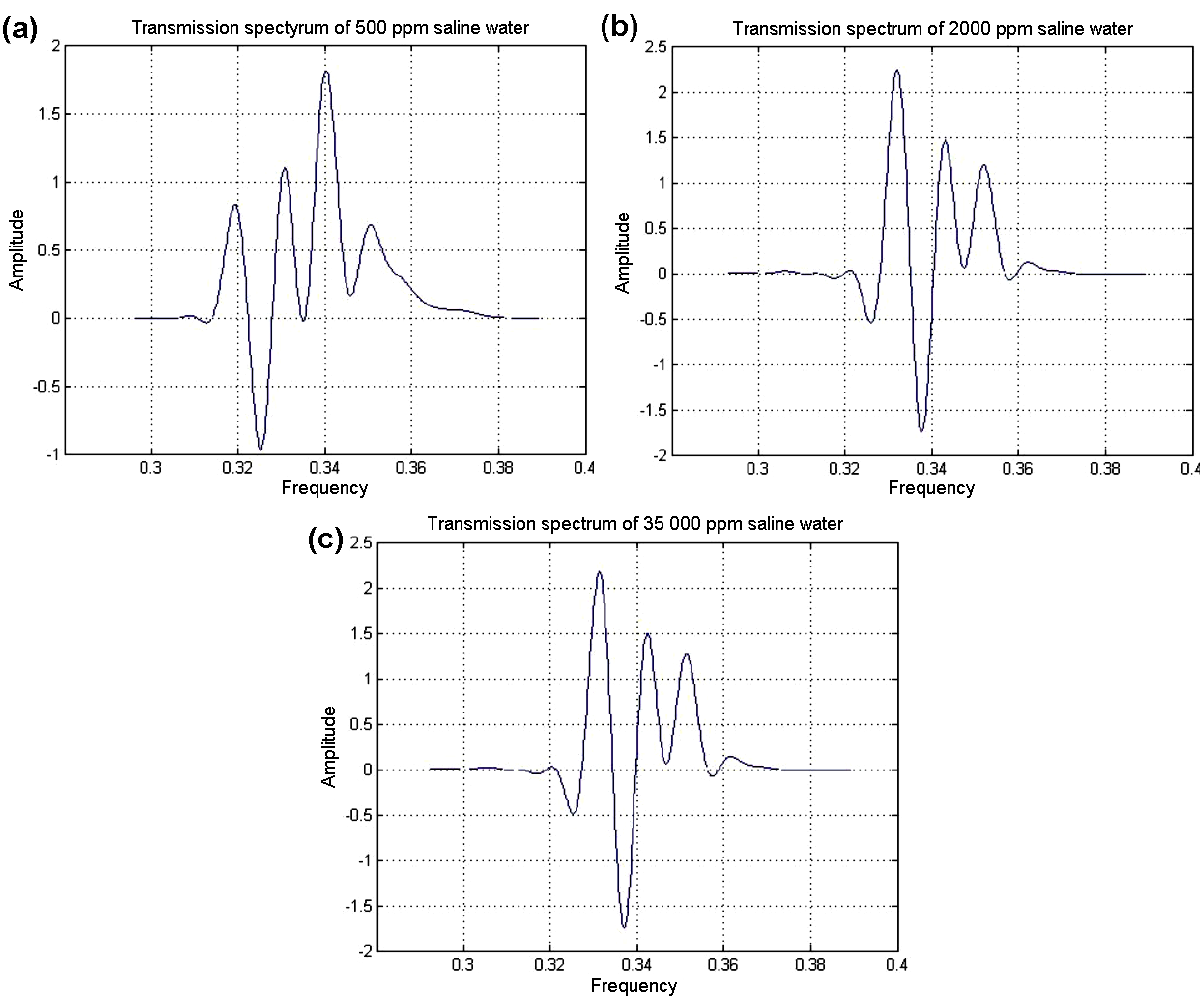
Figure 5. Transmitted spectrum for (a) 500ppm saline water, (b) 52000ppm saline water, and (c) 35000ppm saline water. The above figures depict transmission spectra with distinct shifts in peak frequencies for different salinities. In (a) a nascent curve of the transmission spectrum until 20% of the outcome is exited immediately, with a dip being followed. These curves indicate that the light intensity drops abruptly around 25% of the frequency range of the input light wave. These lines of frequency again tend to achieve maxima and do so at exactly 50% of the frequency spectrum. This is an indication of the highest possible absorption of the intensity of an input light wave that may be a cause of polarization in the vicinity of the waveguide of the proposed structure. This velocity of intensity increase will again tend to become sluggish and abruptly embraces an exponential decay, for which the trapping of light in the waveguide begins to throw off a certain frequency of harmonic wave that tends to create a disruptive interference of the travelling pulse of Gaussian mode. In (b) we can observe that the salinity of water, being an analyte as compared against (a), is increased in concentration by 300%. Here the entire spectrum is exactly the reciprocal of (a) in that the dip has happened in the first phase of the frequency shift, while here the same has happened in the second. Also, as against (a), the light intensity abruptly decreases before the center of the frequency spectrum is achieved. Thereby the absorption and reflection that have taken place before the identification of light intensity at the output become noticeable; only after the frequency of the spectra are over the central frequency of operation will the light intensity become noticeable twice. The curve remains nascent for around 30% of the applied frequency and vigorously excites until 60%. This excitement is immediately damped with a scattering time of under 0.5 units of intensity and remains nascent throughout. This signature curve of the transmission spectrum is incorporated into the database of the